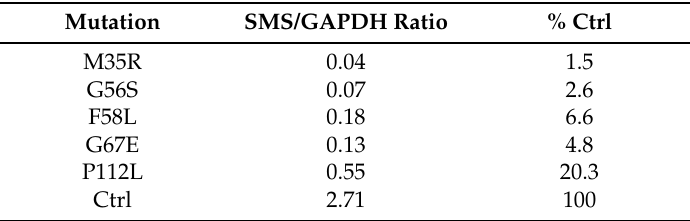
Table 2. Densitometric analysis of bands present in denatured